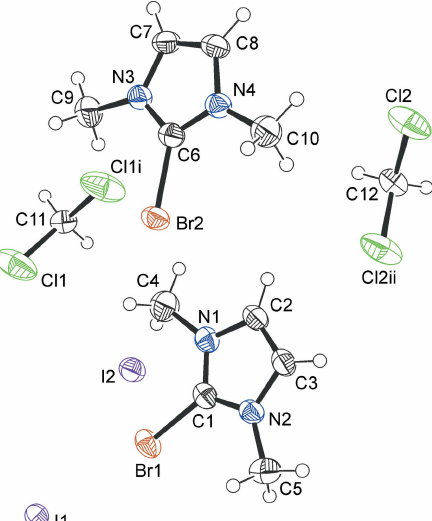
Figure 3 The molecular structure of the iodide 3 , showing the atom labels and 50% probability displacement ellipsoids for non-H atoms. [Symmetry code: (i) 1 (cid:3) x , 1 (cid:3) y , (cid:3) z .]